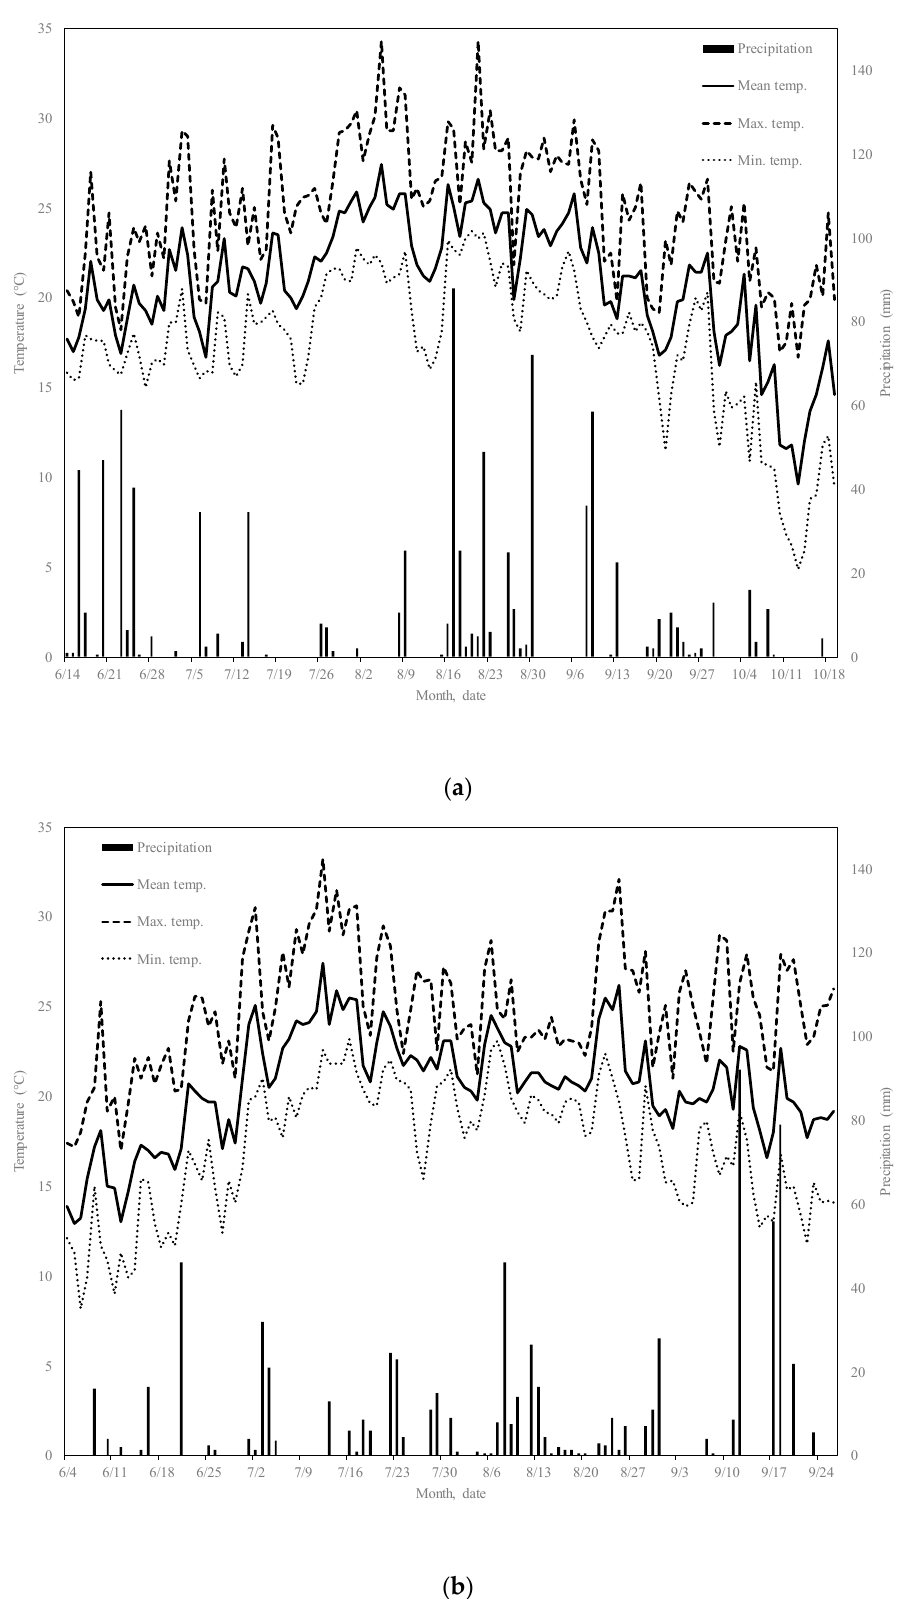
Figure 2. Chronological changes of weather conditions in Rikuzentakata city. ( a ) 2016. ( b ) 2017. The data were obtained using the Automated Meteorological Data Acquisition Sys- tem [25].